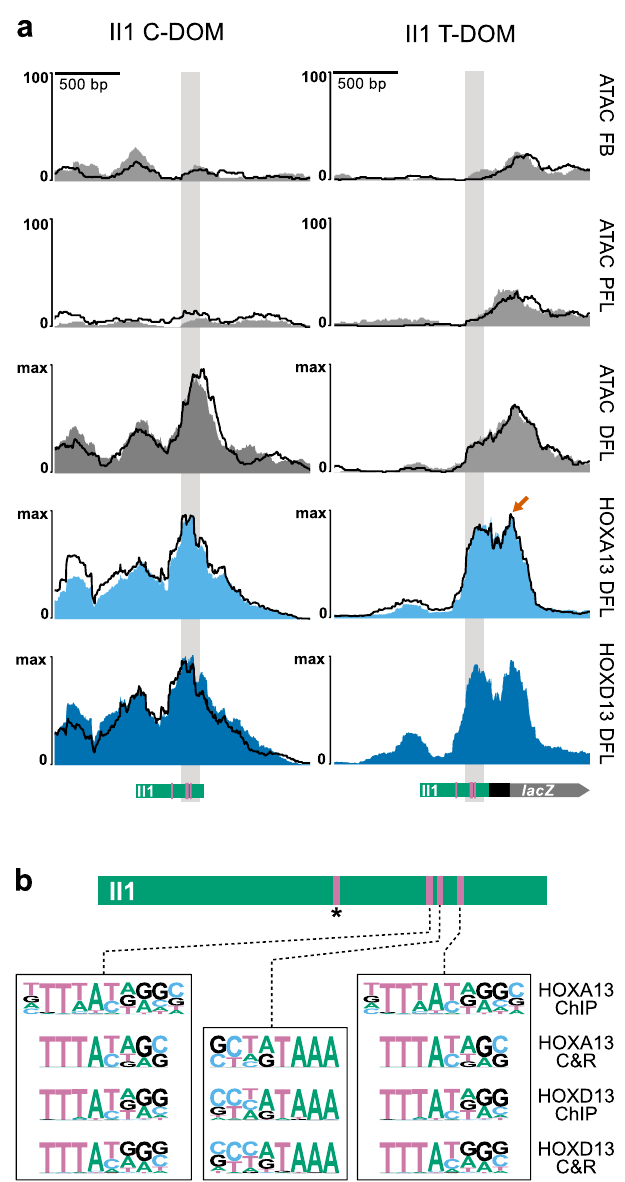
Fig. 3 HOX13 transcription factor proteins bind to the II1 enhancer in T-DOM. a ATAC-Seq and CUT&RUN reads mapped to the II1 enhancer sequence, either in its native environment within C-DOM (left column; mm10 chr2:74,074,674-74,076,672), or its targeted recombination site within T-DOM (breeding line 542, right column; mm10 chr2:75,268,925- 75,270,923). The II1 C-DOM element is not accessible by ATAC-Seq in E12.5 forebrain (FB), nor in proximal forelimb cells (PFL) samples. At E12.5 it becomes highly accessible in distal forelimb cells (DFL) and is strongly bound by HOX13 proteins. The II1 element in T-DOM has low accessibility in the FB and PFL samples, even though there is a high transcription of the transgene in PFL. Like the II1 element in C-DOM, the II1 enhancer in T-DOM is occupied by HOX13 proteins in distal limb cells. It also shows an additional peak over the HBB promoter (orange arrow). This peak is likely a non-speci fi c signal resulting from promiscuous MNase activity used in the CUT&RUN technique. In all samples but HOXD13 in the II1 T-DOM allele, experiments were performed in duplicate. One biological replicate is plotted as a solid color and the other is shown as a superimposed black line ( n = 2). Green rectangles below indicate the position of the II1 enhancer element relative to the peak signal; the position of the four HOX13 binding sites is indicated by pink lines. b On top is a schematic of the II1 enhancer element with the four HOX13 motifs indicated as pink bars. The pink bar with an asterisk indicates the motif position that is not near the HOX13 and ATAC peaks. At the bottom are the three HOX13 motifs identi fi ed by HOMER motif discovery in the CUT&RUN experiments here and the E11.5 whole forelimb ChIP-seq 25